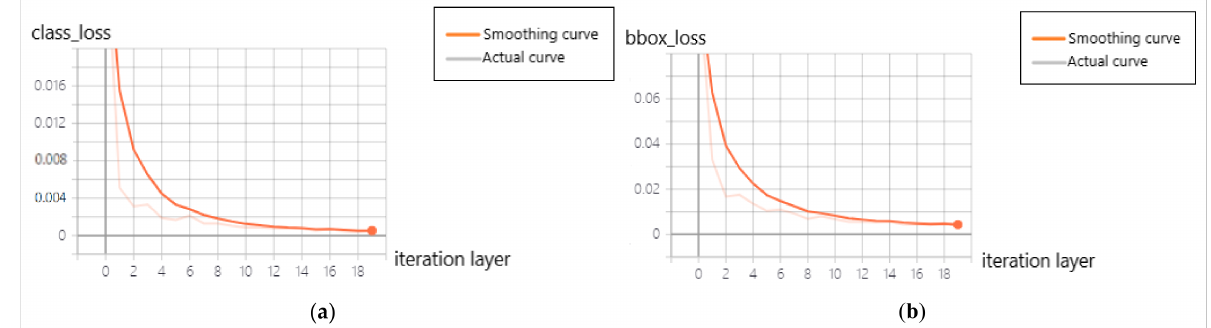
Figure 18. Mask R-CNN loss function 2. ( a ) Class loss, ( b ) bbox loss.